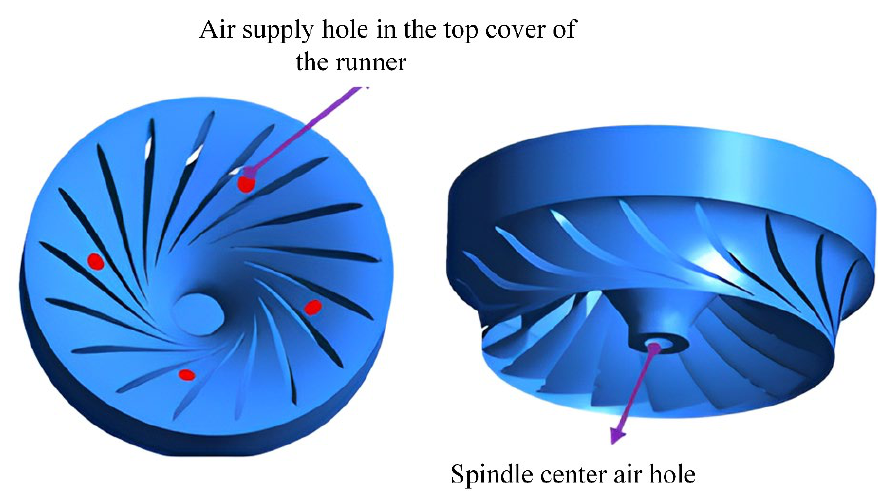
Figure 22. Schematic diagram of the positions of different air supply holes [73].